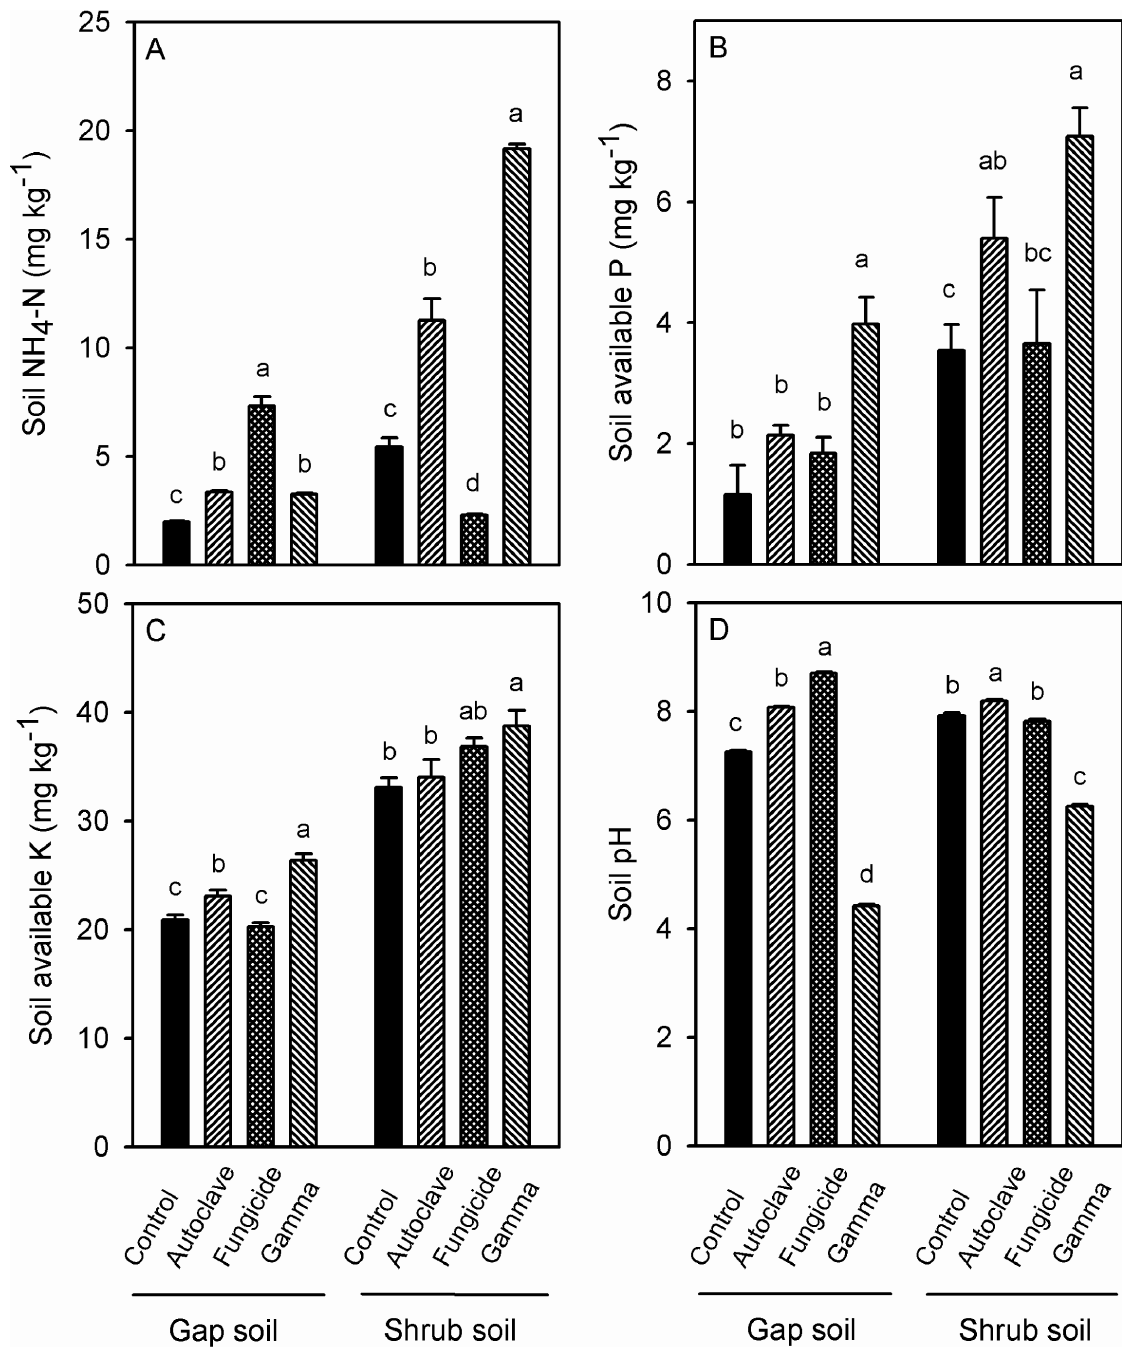
Figure 1. Changes in soil NH -N (A), soil available P (B), soil available K (C), and soil pH (D) with different biocidal treatments. Data 4 are means + 1 SE (n = 5). Different letters within a soil type indicate statistically significant differences (p < 0.05) among